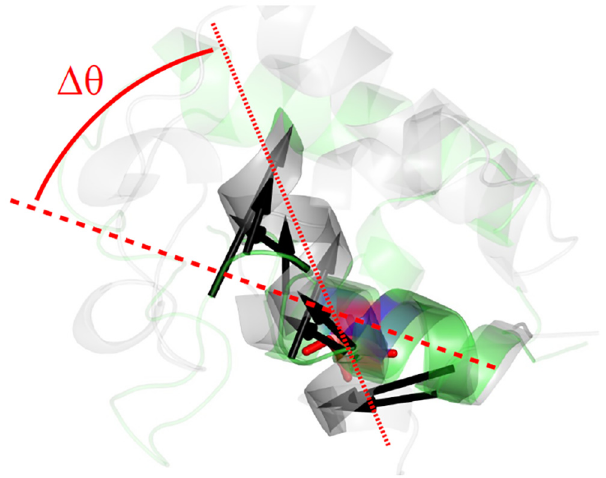
Fig 7. Change in the relative orientation between two α -helices in Escherichia coli acyl carrier protein (ACP). Ligand free (PDBid: 1ACP, chain A) and ligand-bound (PDBid: 2FAE, chain B) are depicted in green and gray respectively. The key position residue I69(red) participates of an H-H inter-SSE contact with V7 (blue). The arrows indicate the directions in which residues move during the conformational transition upon ligand binding. Δθ = θ — θ ’ , being θ and θ ’ the angles between H4 α -helix (Q66-H75) and H1 α -helix (E4-Q14) in ligand free and ligand-bound structures